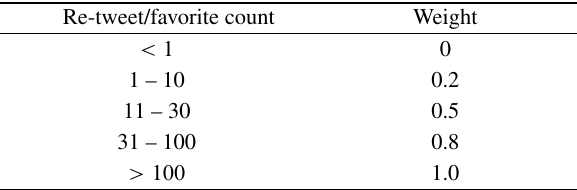
Table 5 Weights for re-tweet/favorite count.